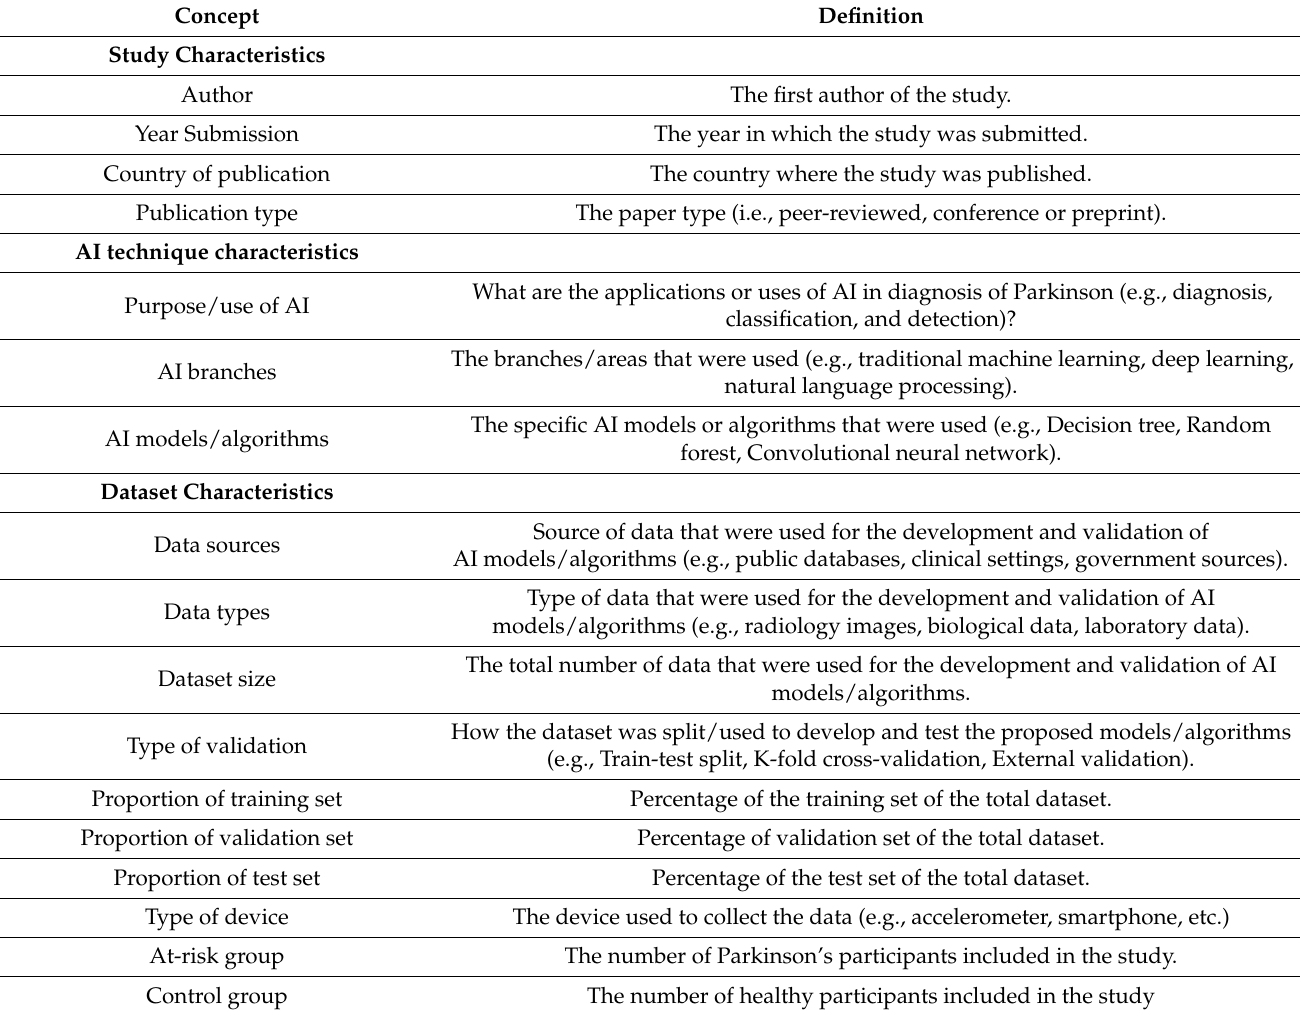
Table A2. Data extraction